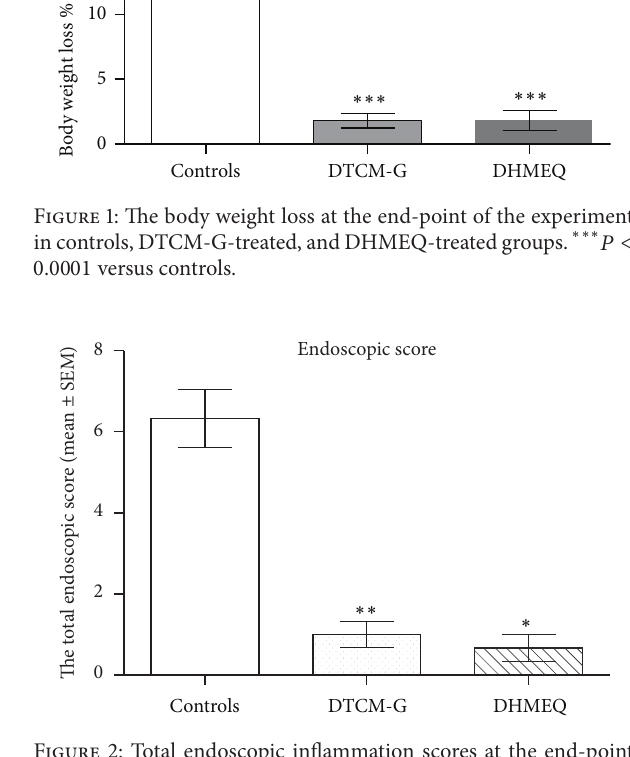
Figure 2: Total endoscopic inflammation scores at the end-point of the experiment in the control, DTCM-G-treated, and DHMEQ- treated groups. ∗ 𝑃 < 0.05 and ∗∗ 𝑃 < 0.01 versus